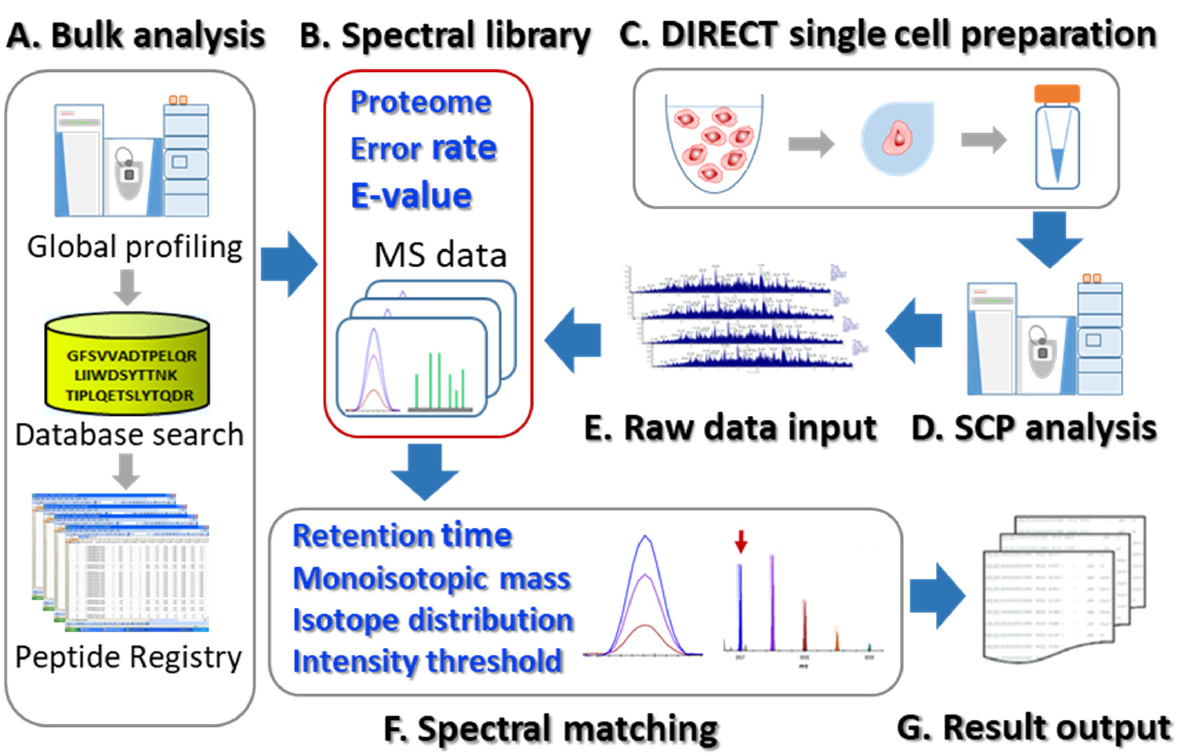
Figure 1. The workflow of the SLB-SCP platform. ( A ) Bulk scale analysis to acquire high-resolution data for library construction. ( B ) Construction of a spectral library with stringent identification criteria. ( C ) Single-cell sample preparation with the DIRECT protocol. ( D ) LC–MS/MS analysis optimized for single-cell proteomics. ( E ) Importing raw data for spectral library-based analysis. ( F ) Peak extraction through spectral matching with the spectral library. ( G ) Generating result output.